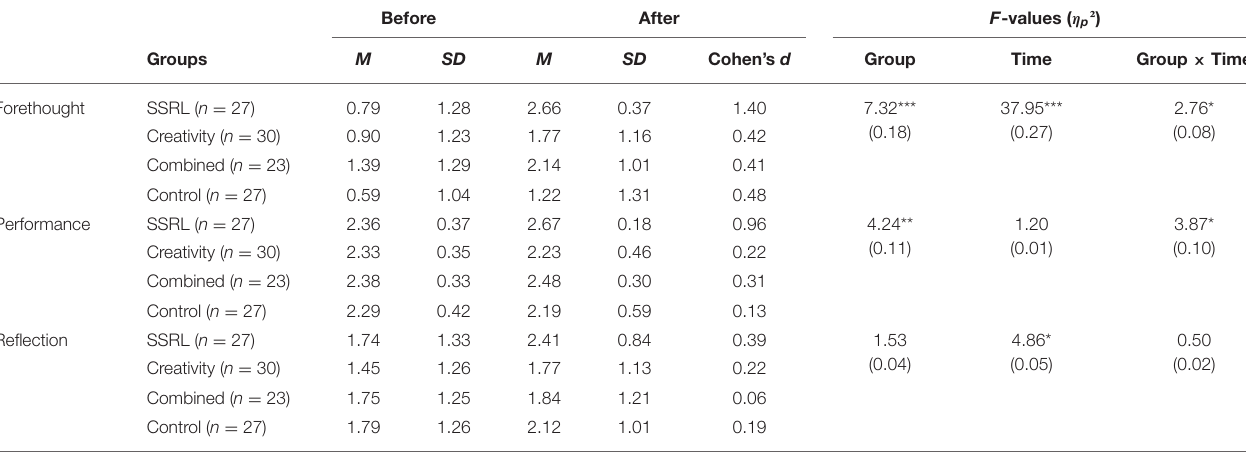
TABLE 3 | Means, SD and F -values for participation in different stages of SSRL during the first part of the task by group and time. Before After F -values ( η p ² ) Groups M SD M SD Cohen’s d Group Time Group × Time